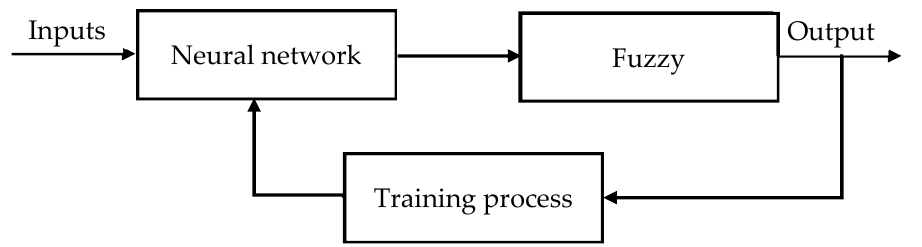
Figure 4. Fuzzy neural system model.